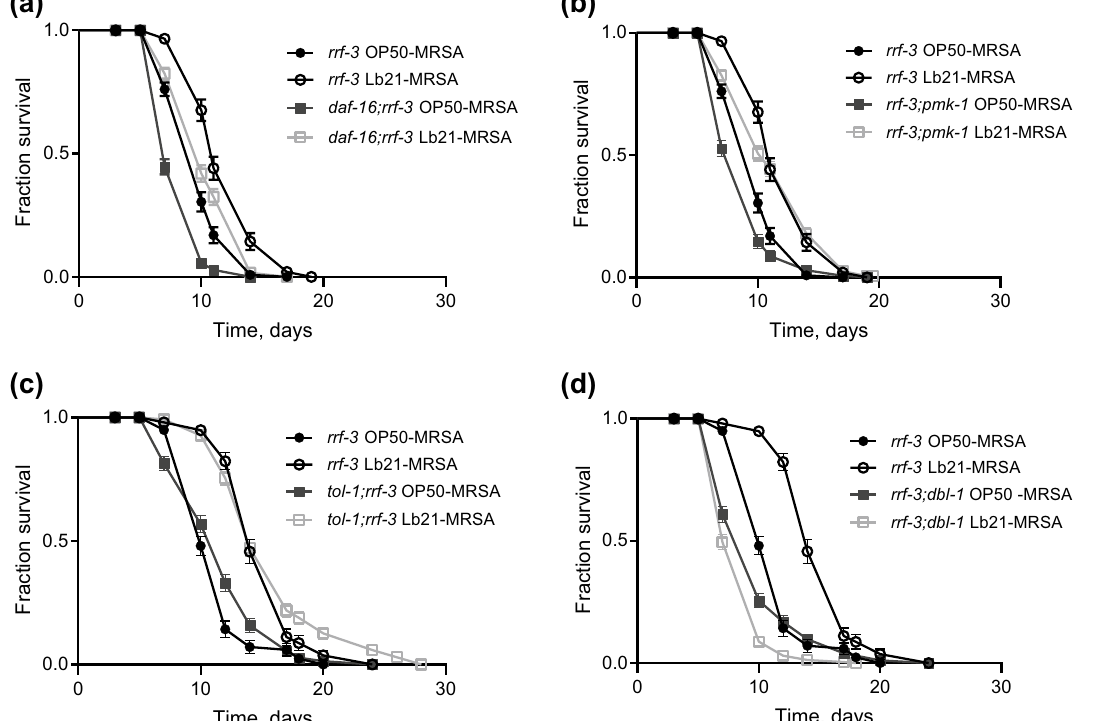
Figure 3. DBL-1 is essential for Lb21-mediated MRSA tolerance. ( a ) Double mutant daf-16 ( mu86 ); rrf- 3 ( pk1426 ) survival compared to survival of rrf-3(pk1426) pretreated with either OP50 or Lb21 for 48 h before being shifted to MRSA 43484. ( b ) Double mutant rrf-3 ( pk1426 ) ;pmk-1 ( km25 ) survival compared to survival of rrf-3(pk1426) pretreated with either OP50 or Lb21 before being shifted to MRSA 43484. ( c ) Double mutant tol-1 ( nr2033 ); rrf-3 ( pk1426 ) survival compared to survival of rrf-3(pk1426) pretreated with either OP50 or Lb21 before being shifted to MRSA 43484. ( d ) Double mutant rrf-3 ( pk1426 ); dbl-1 ( nk3 ) survival compared to survival of rrf-3(pk1426) pretreated with either OP50 or Lb21 before being shifted to MRSA 43484. Graphs show a representative experiment from several independent experiments. See Table S1 for mean ± SD and log-rank test